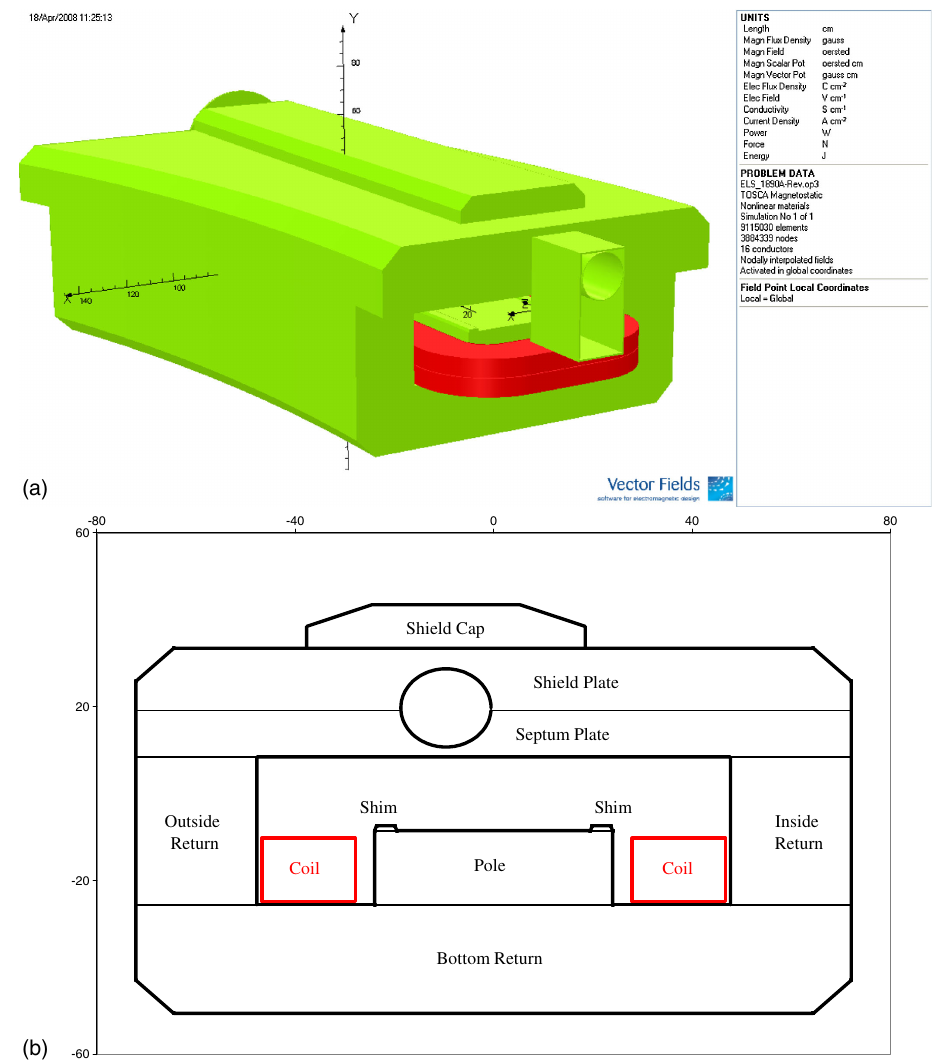
FIG. 3. (Color) (a) Entrance view of ELS simulation model. (b) Upstream view of a cross section through the center of ELS